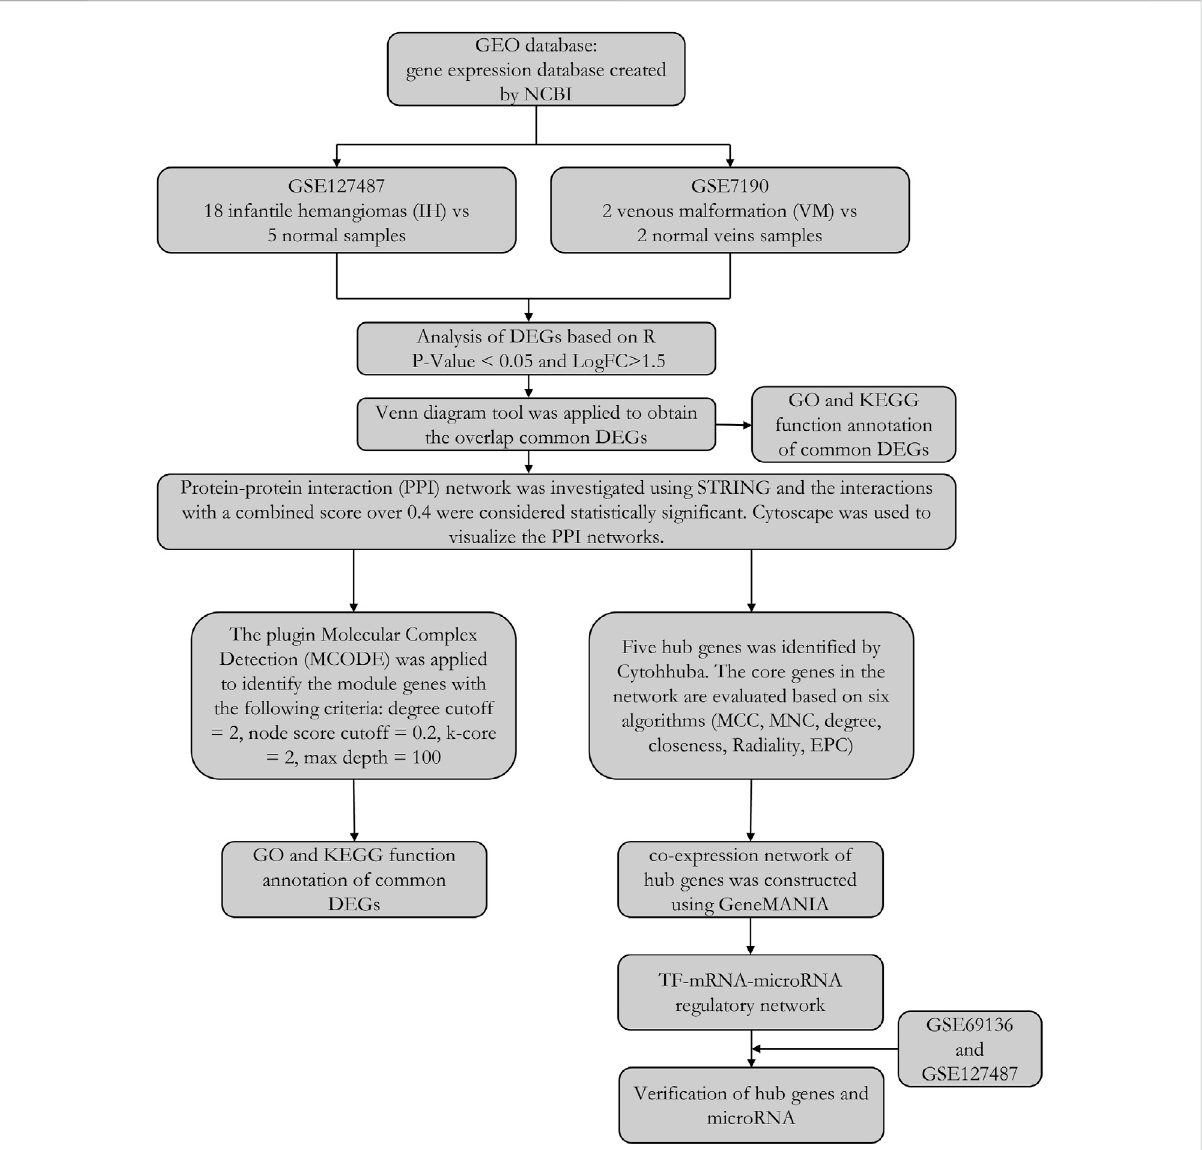
FIGURE 1 The work fl ow of this